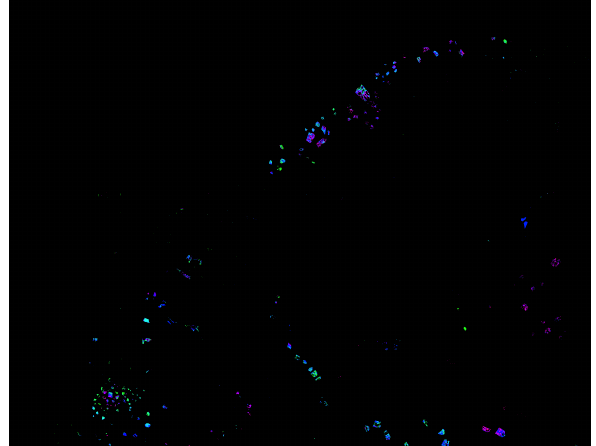
Figure 10. STL-map of pattern 3 (cid:41) 3 (cid:41) 3 (cid:41) 2 (cid:41) 2 (cid:41) 2 (cid:41) 2 (cid:41) 2 (cid:41) 2 , between the towns of Saint-Paul and